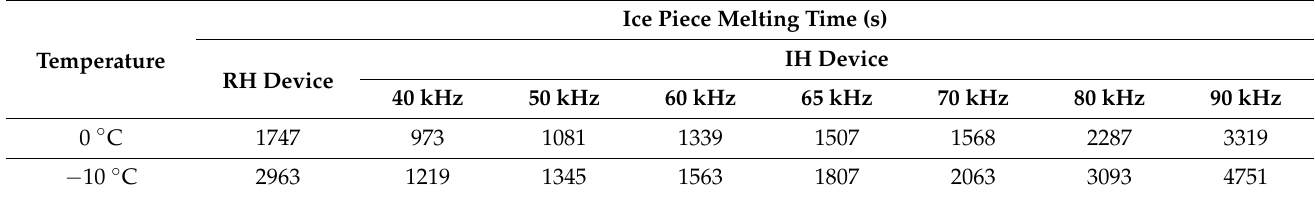
Table 1. Times of ice piece melting by RH and IH devices at various operating conditions